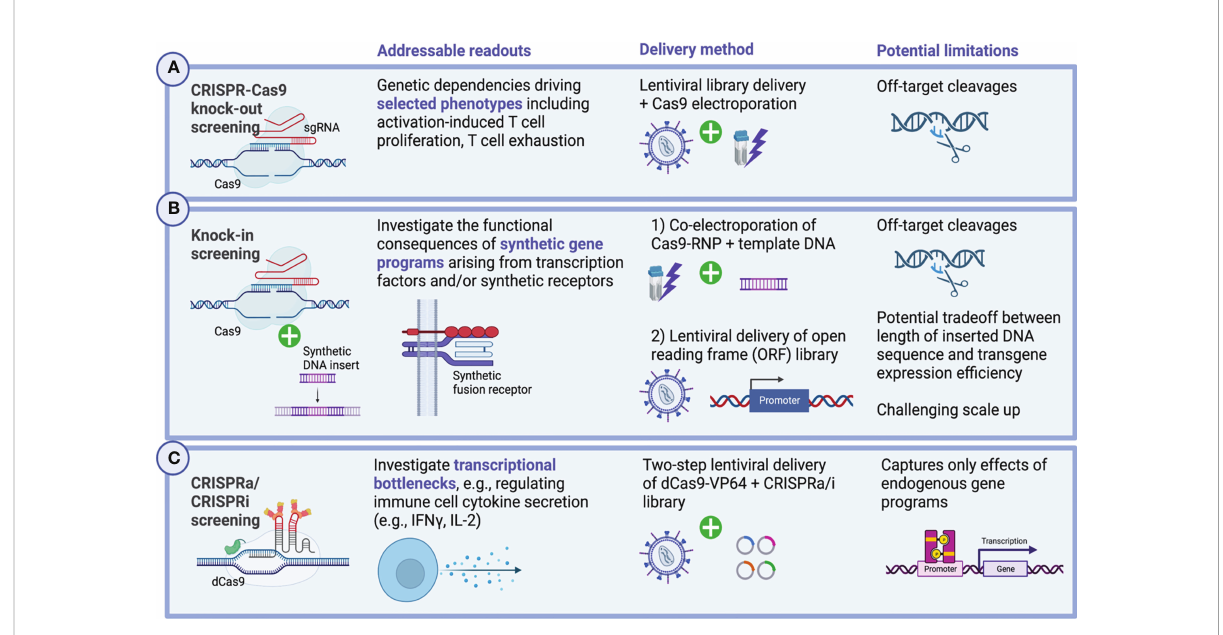
FIGURE 4 Genome-wide CRISPR screening in primary human immune cells. Forward genetic screening enables the unbiased discovery of genetic dependencies governing cellular functions. Applied to the context of primary immune cells, including genetically engineered immune effector cells, these large-scale discovery approaches have in recent years contributed greatly to develop a deeper understanding of the molecular mechanisms regulating activation-induced T cell proliferation, cytokine secretion and functional exhaustion. Technically, a set of different design approaches exist and enable to address distinct biological questions and confer relationships between genotype and phenotype. (A) Pooled CRISPR/Cas9 knock-out screens allow to interrogate in a massively parallel manner the functional consequences of genetic deletions at genome-scale. In primary human T cells as well as CAR-T cells, lentiviral gRNA library delivery is typically followed by transient Cas9 delivery via electroporation (162 – 165). Multiple different readouts have previously been investigated including activation-induced T cell proliferation